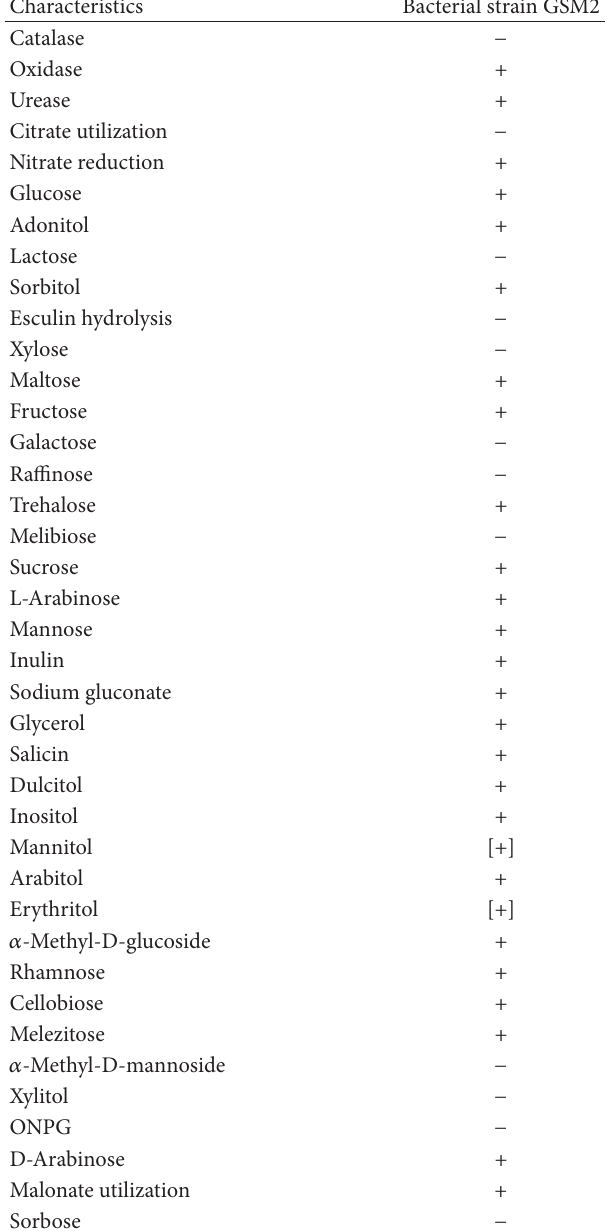
Table 1: Biochemical and sugar utilization tests of bacterial strain